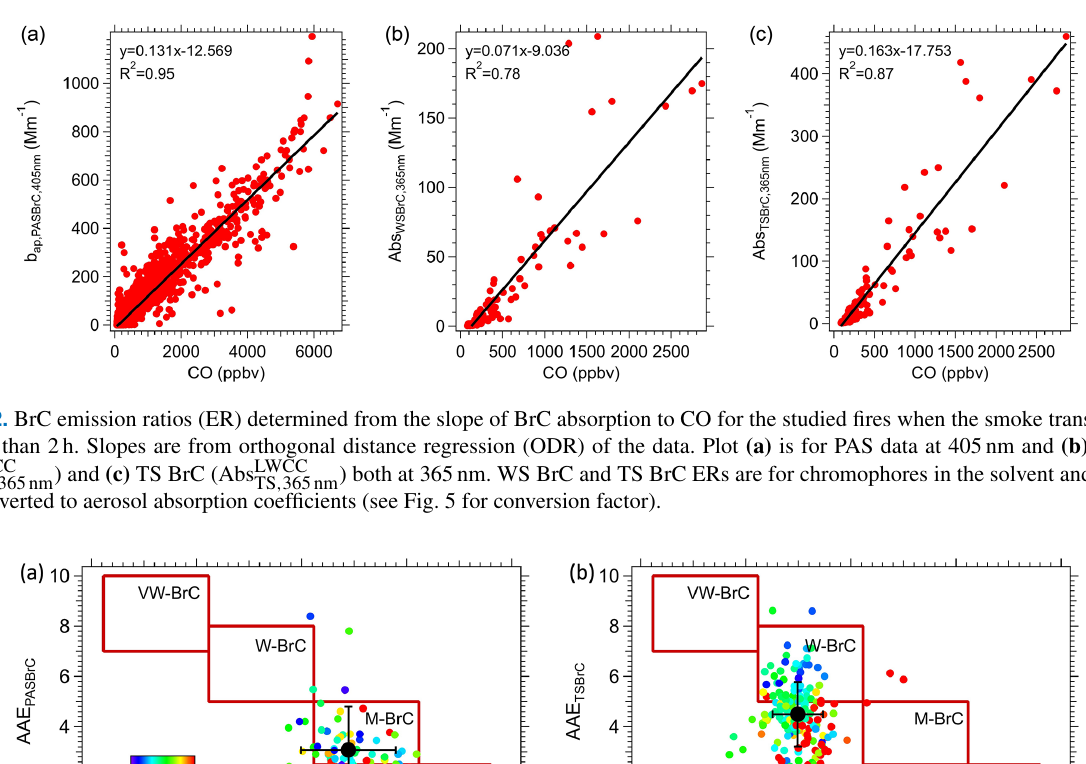
Fig. 5a, the dotted black line is the “bare” (pure) rBC ab- sorption determined from the rBC mass concentration mea- sured by the SP2 (rBC concentration was 4.8 µg m − 3 ) deter- mined by Eq. (3). The effect of the BC coating enhancement ( E λ = 1.6) is also shown, and the resulting overall BC light absorption is the solid black line. Compared to the PAS data, this coated rBC absorption contributed 61 % to the total light absorption at 664 nm but only about 36 % at 405 nm due to BrC contributions. The brown line in Fig. 5a is b ap , predicted ,λ , or the ambient light-absorption coefficient of TS BrC mea- sured by the LWCC after applying K λ (conversion of solu- tion to particle BrC, b ap , TSBrC ,λ = K λ · Abs LWCC ) added to TS ,λ the BC absorption (first term in Eq. 4).The brown shading is then the aerosol particle TS BrC ( b ap , TSBrC ,λ ). The red dia- mond markers in Fig. 5a are absorption measurements made by the PAS at three wavelengths, representing the overall aerosol absorption. The red curve is from fitting the three PAS measurement points with a power law ( b ap , PASBrC ∼ λ − 2 . 09 ). Note that the area between the red curve and